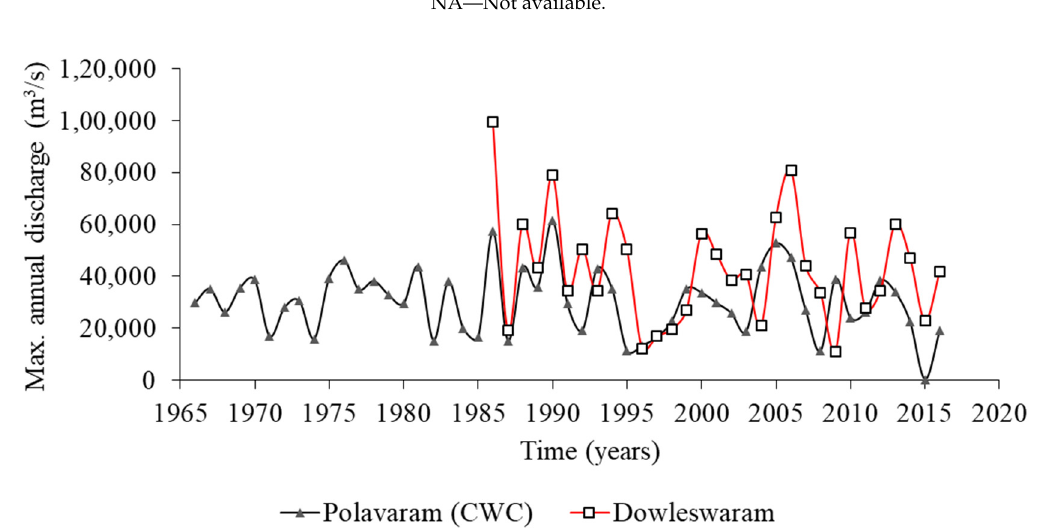
Figure 3. Observed peak annual discharge at Polavaram and Dowleswaram gauge.